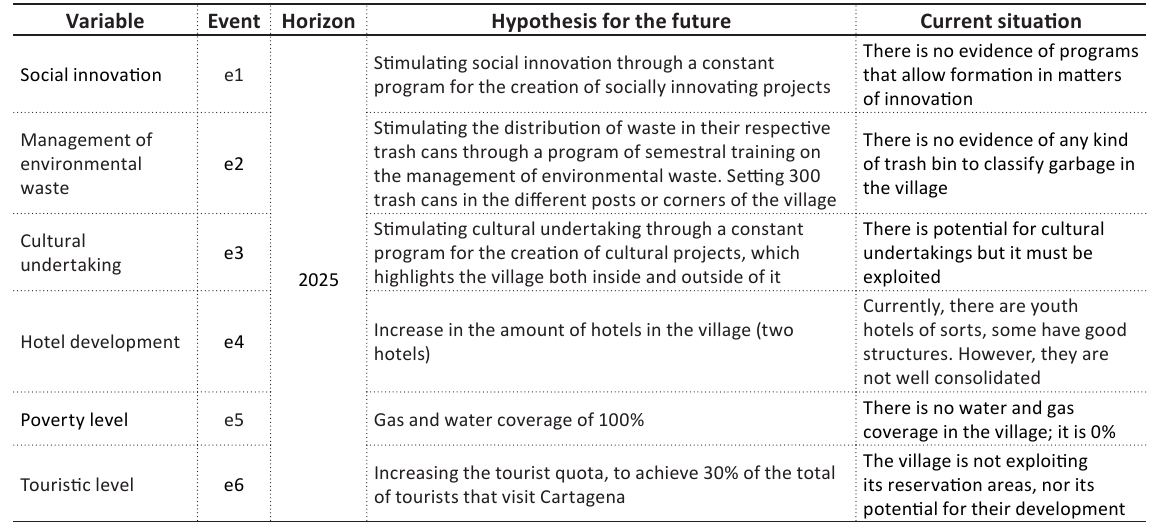
Table 7. Hypothesis for the formulation of